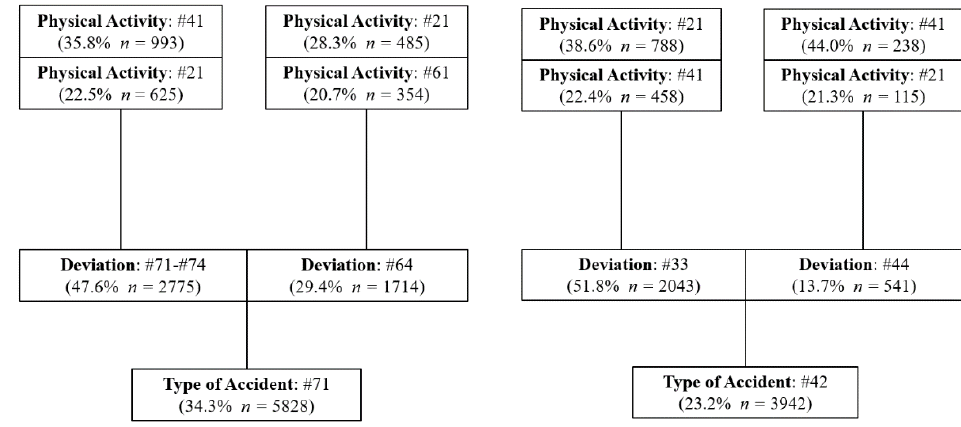
Figure 1. Characteristics of the Type of Accident in UG.